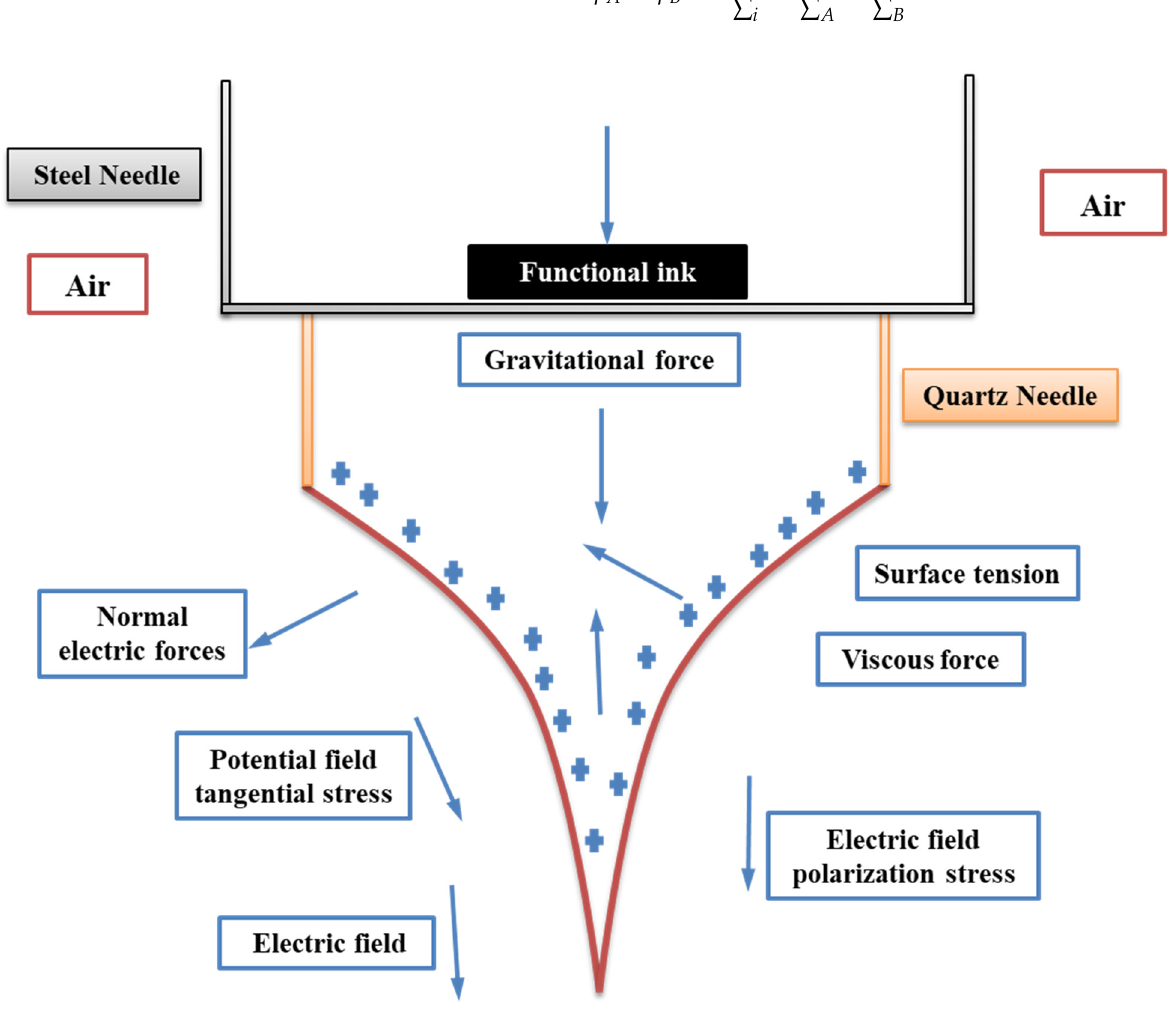
Figure 1. Influence of different forces around the Taylor cone during DoD e-jet printing method.